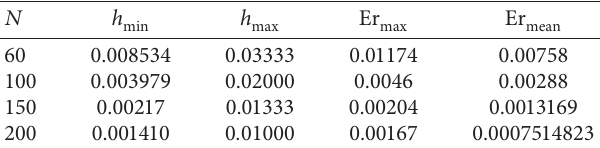
Figure 7: The δ − ziti solution. Table 4: The committed error using several values of nodes number N .